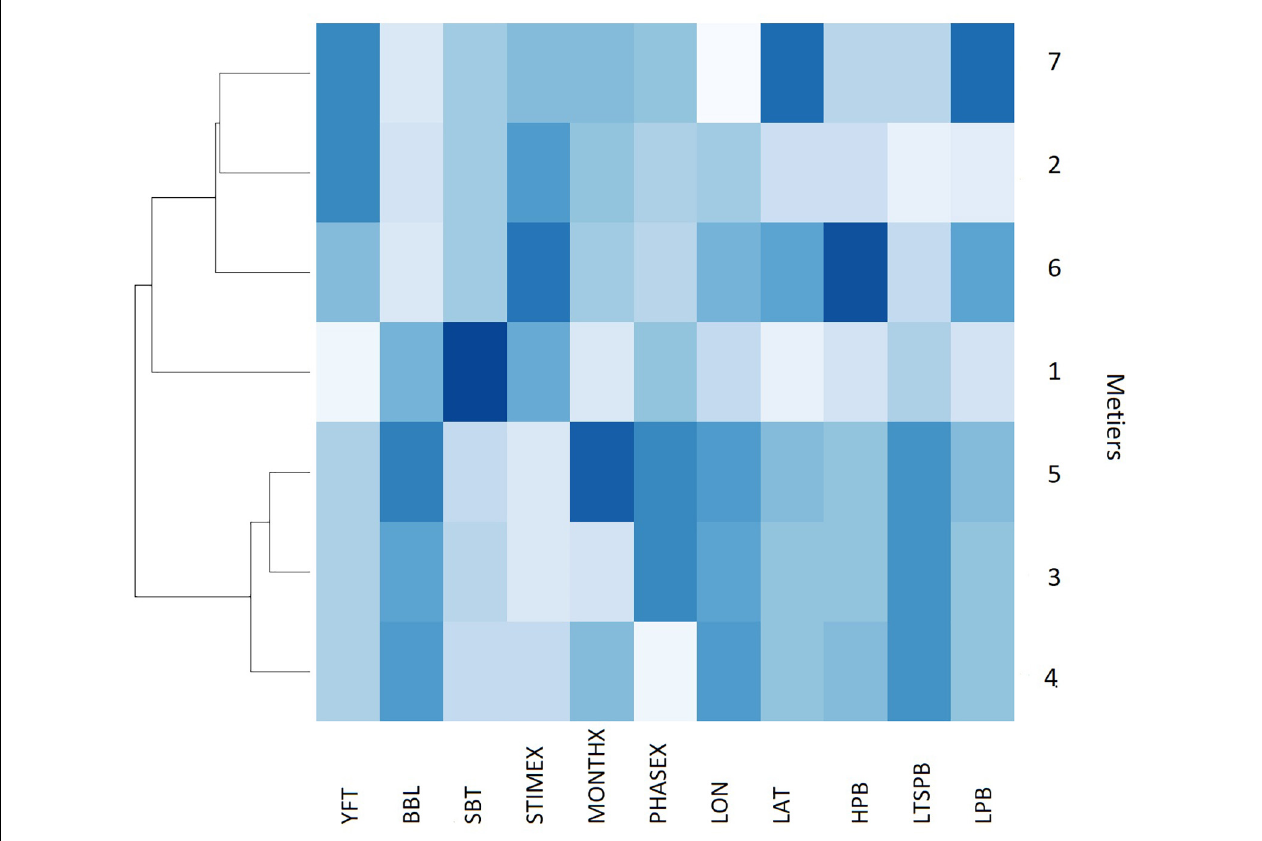
FIGURE 5 | Heat map dendrogram of the similarity [based on color density with dark (light) shading meaning high (low) relative value] between the seven métiers in the Eastern Tuna and Billfish Fishery (ETBF) for the selected fisher decision and catch variables between 2010 and 2017. See Table 1 for description of